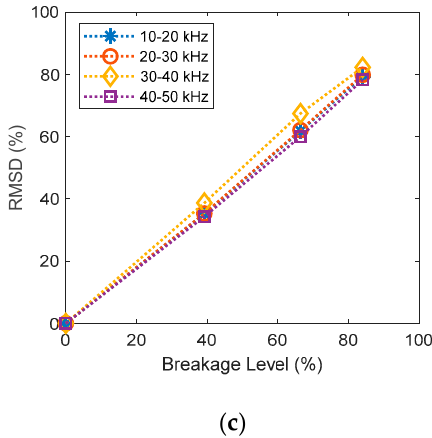
Figure 6. The RMSD metric of imaginary impedance signatures: ( a ) structural damage; ( b ) sensor debonding; ( c ) sensor breakage.